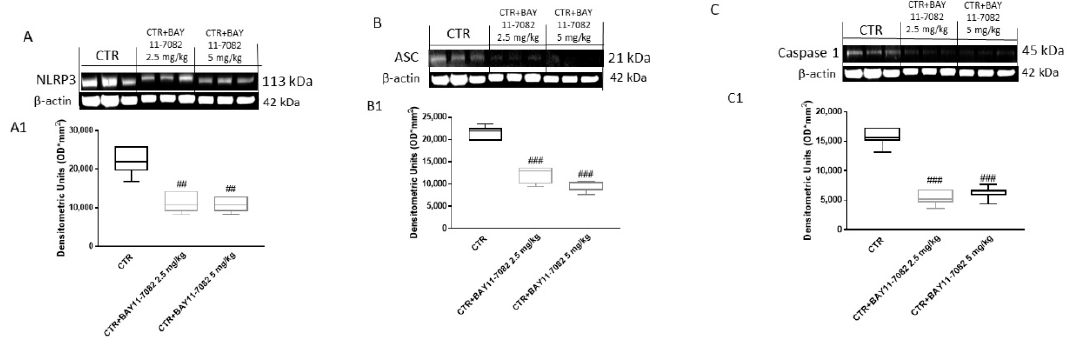
Figure 8. Effect of BAY-117082 on NLRP3 inflammasome pathway in CAL27 xenograft model. Blots reveal that treatment with BAY-117082 at doses of 2.5 and 5 mg/kg was able to reduce NLRP3, ASC, and caspase 1 expression compared to control group. Data are representative of at least three independent experiments. ( A ) ## p < 0.01 vs. CTR; ( B ) ### p < 0.001 vs. CTR; ( C ) ### p < 0.001 vs. CTR.